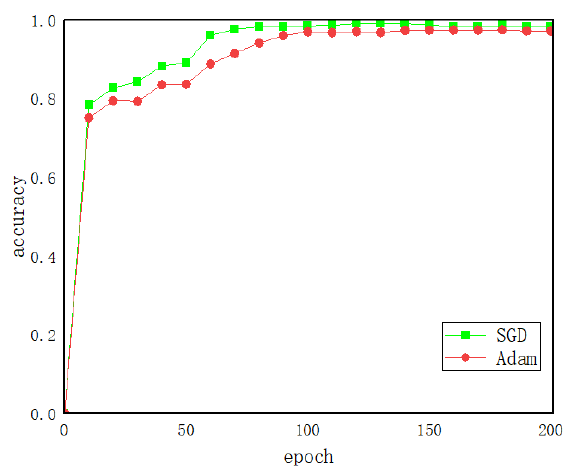
Figure 11. The accuracy of the SGD and Adam optimization functions in YOLOX in the test set.